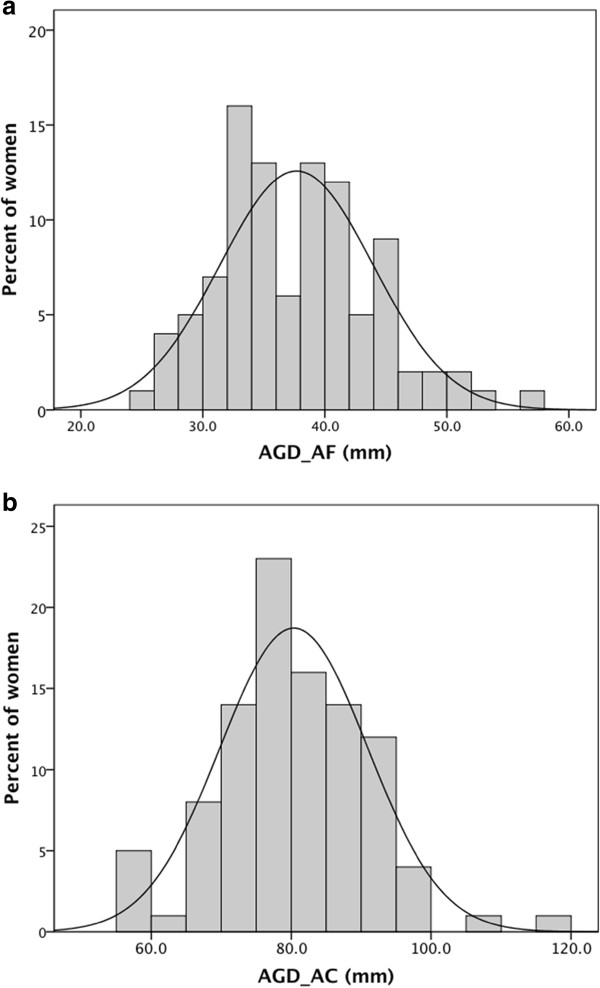
Frequency distributions of (a) AGDAF and (b) AGDAC in the MYWS.